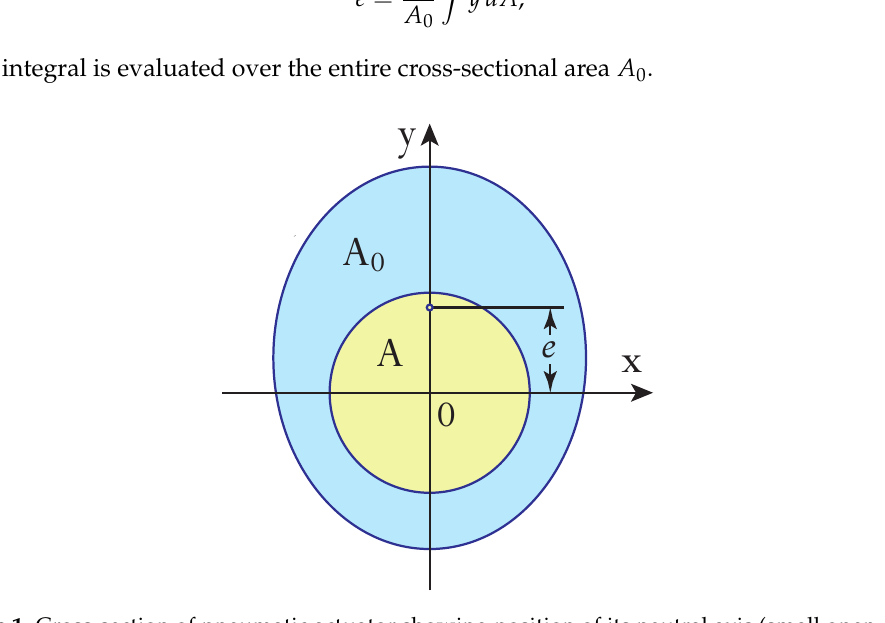
Figure 1. Cross-section of pneumatic actuator showing position of its neutral axis (small open circle) and illustrating parameters e , A , and A 0 . Shaded in blue and yellow are the polymer tube and the pressurized hollow core of the